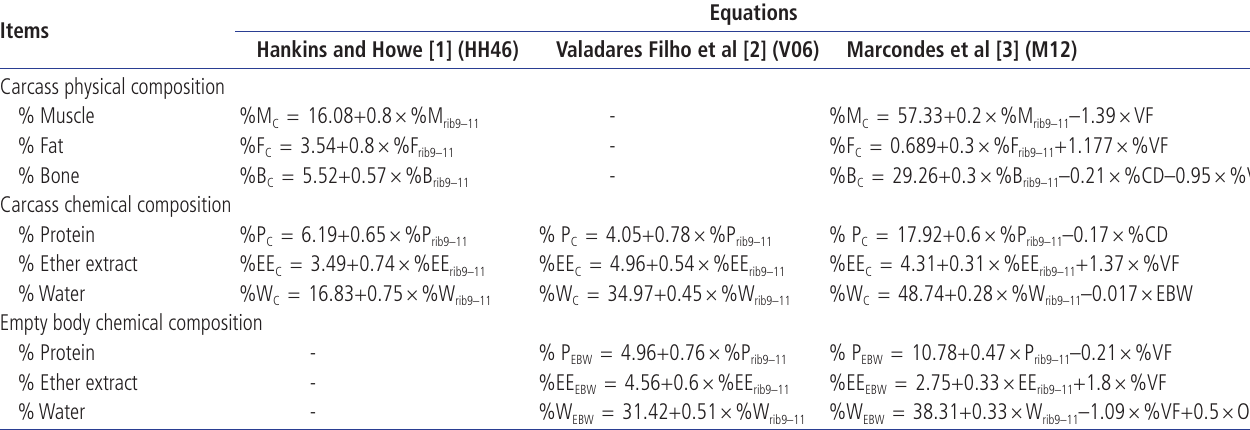
Table 2. Equations used to estimate the body composition in bulls Items